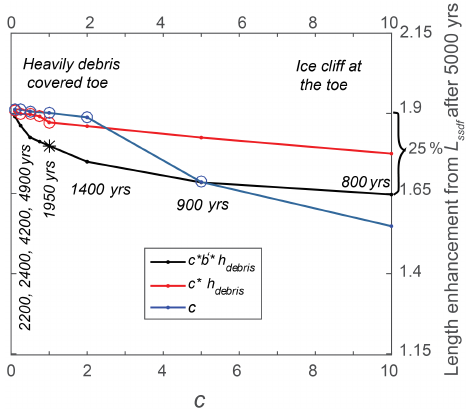
Figure B1. Exploring various choices for the ˙ d term parameteriza- flux tion. Glacier lengths are normalized by the steady state debris free glacier length ( L ssdf ). Irrespective of the choice of the ˙ d term pa- flux rameterization the steady glacier length is nearly doubled. For all simulations ˙ d flux is 3.2m 3 m − 1 yr − 1 . The glacier will never reach steady state for choices where ˙ d term cannot evolve to equal ˙ d flux . flux = c and c is less than 3.2m 3 m − 1 yr − 1 . Cir- This occurs when ˙ d term flux cles represent simulations in which M surface (the total debris mass on the glacier) and glacier length did not reach steady state after 5000years. The time labels show how long it took for the glacier to = c ˙ bh reach steady state for the cases when ˙ d term debris . All simu- flux = c ˙ bh lations presented outside of this plot use the ˙ d term debris pa- flux rameterization with c = 1 ( ∗ in this